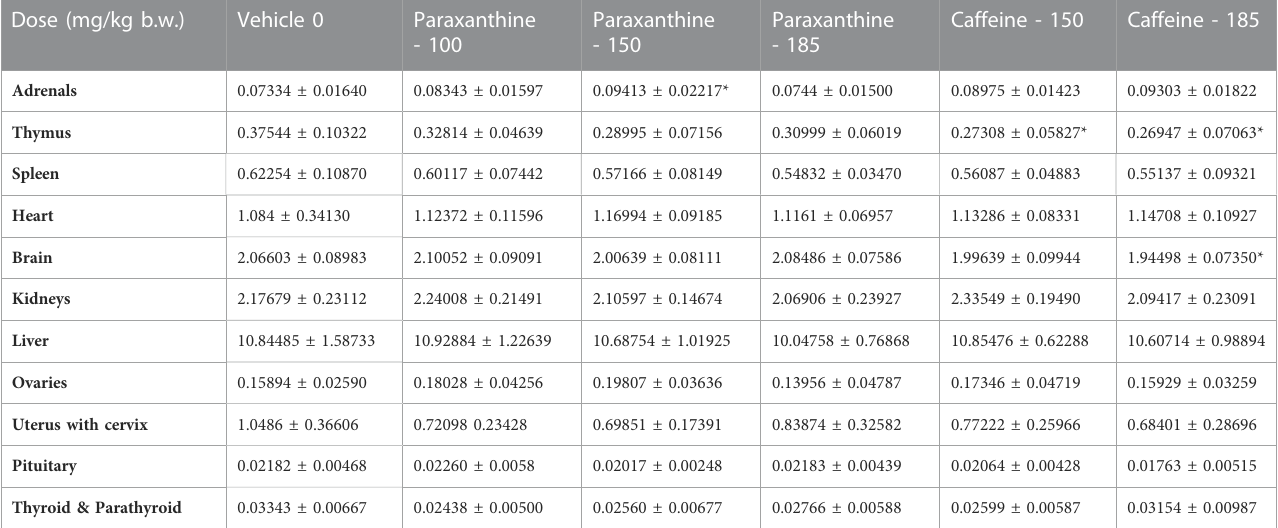
TABLE 7 Summary of absolute organ weights for females inthe repeat-dose 90-day toxicity study. Values represent mean ± SD.*Statisticallysigni fi cant( p < 0.05) with respect to the vehicle group. Dose (mg/kg